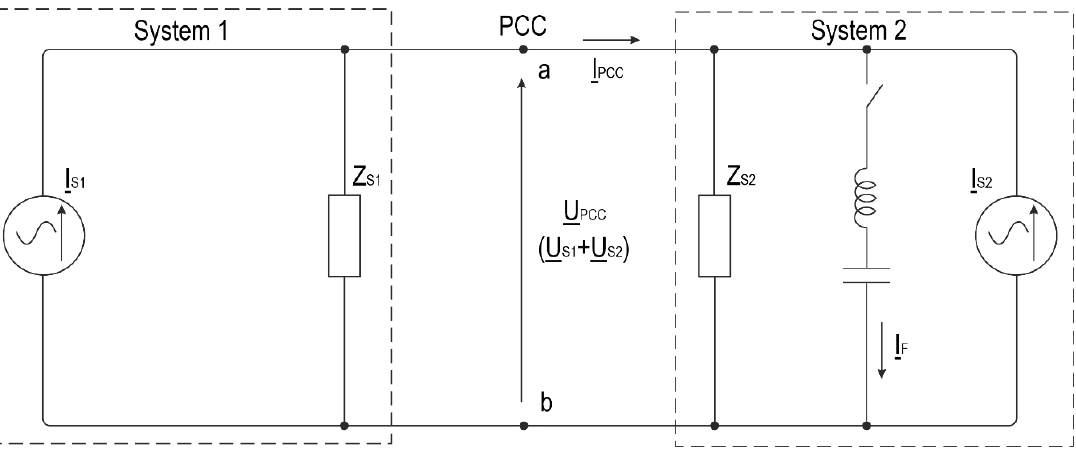
Figure 3. Norton equivalent circuit of a simple system with passive harmonic filter.